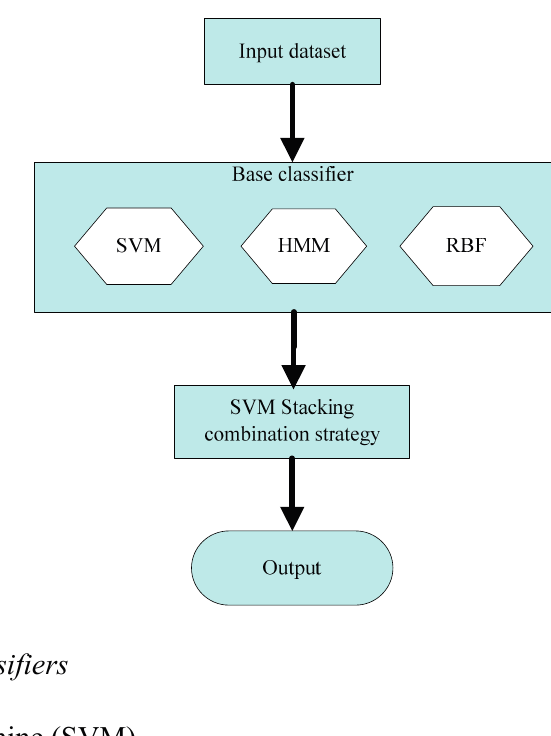
Figure 1. The structure of heterogeneous ensemble